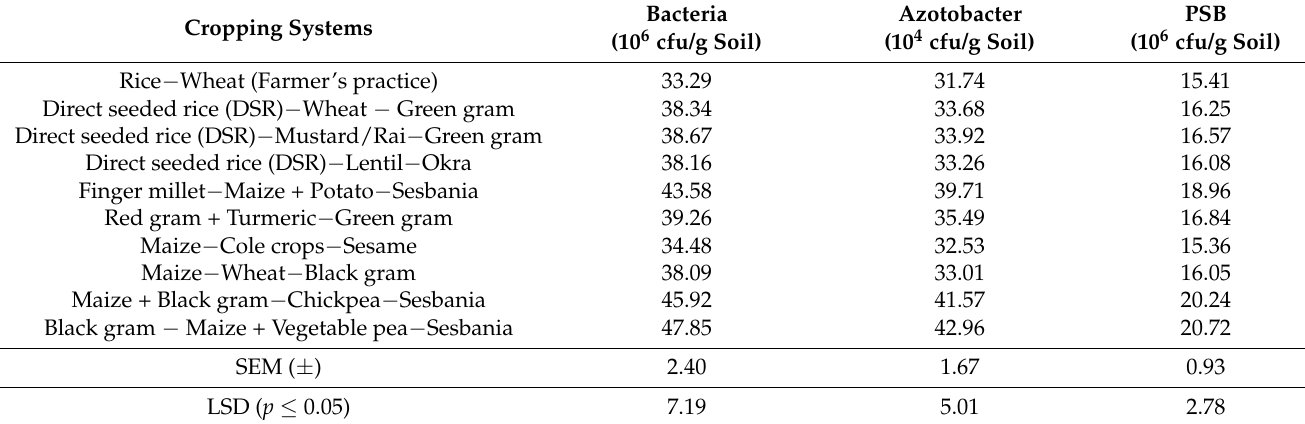
Table 9. Soil microbial population is influenced by a diversified cropping